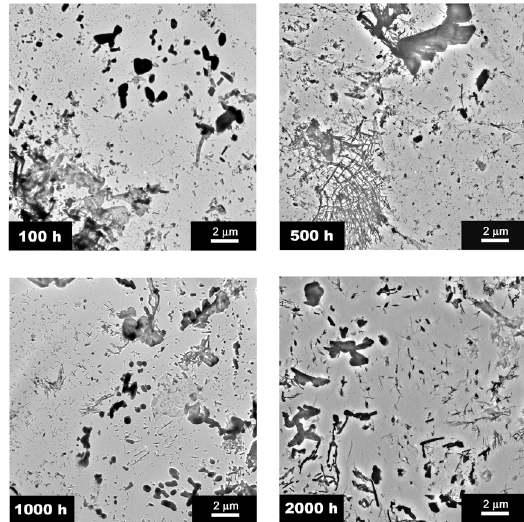
Figure 7: Ferritic-bainitic steel transmission electron micrographs at 600°C and 100, 500, 1000 and 2000 h of